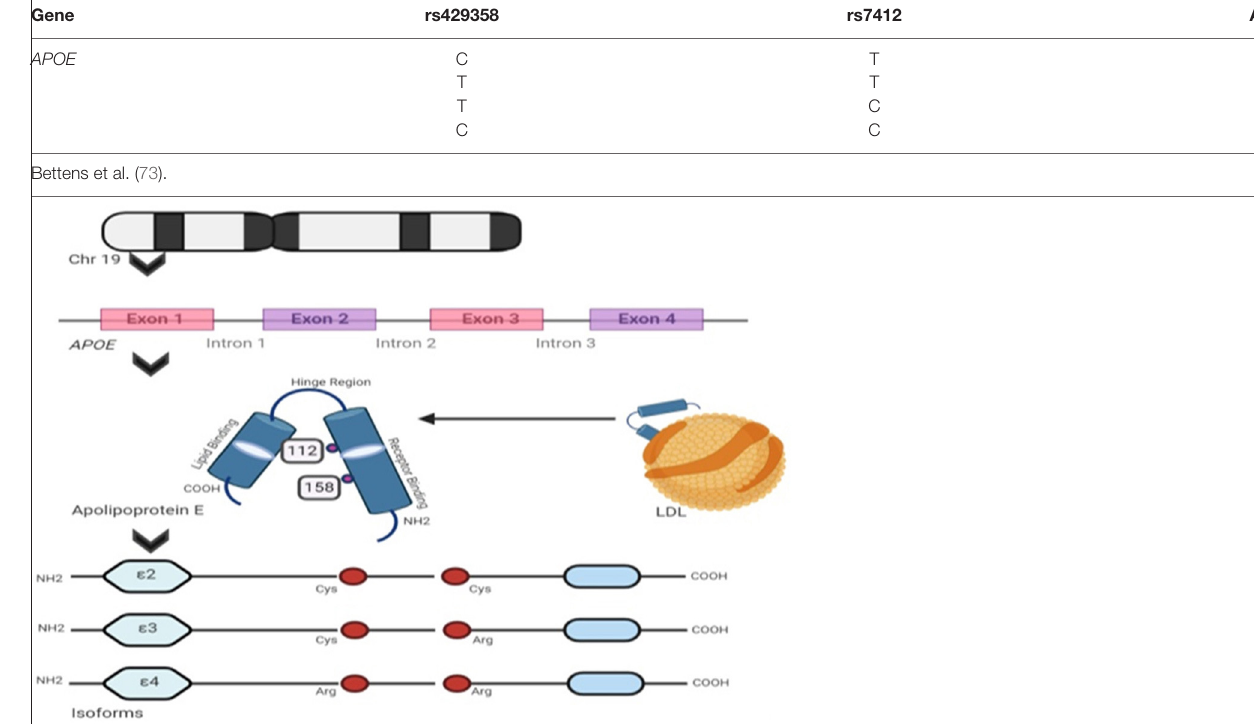
FIGURE 3 | Apolipoprotein E isoforms and its genetic integrity: the figure shows APOE allelic variants encoded by the APOE gene that transcribes Apolipoprotein E isoforms and the table lists all the major genotype specific single nucleotide polymorphism (SNP) variants and their nucleotide transformations seen, respectively.